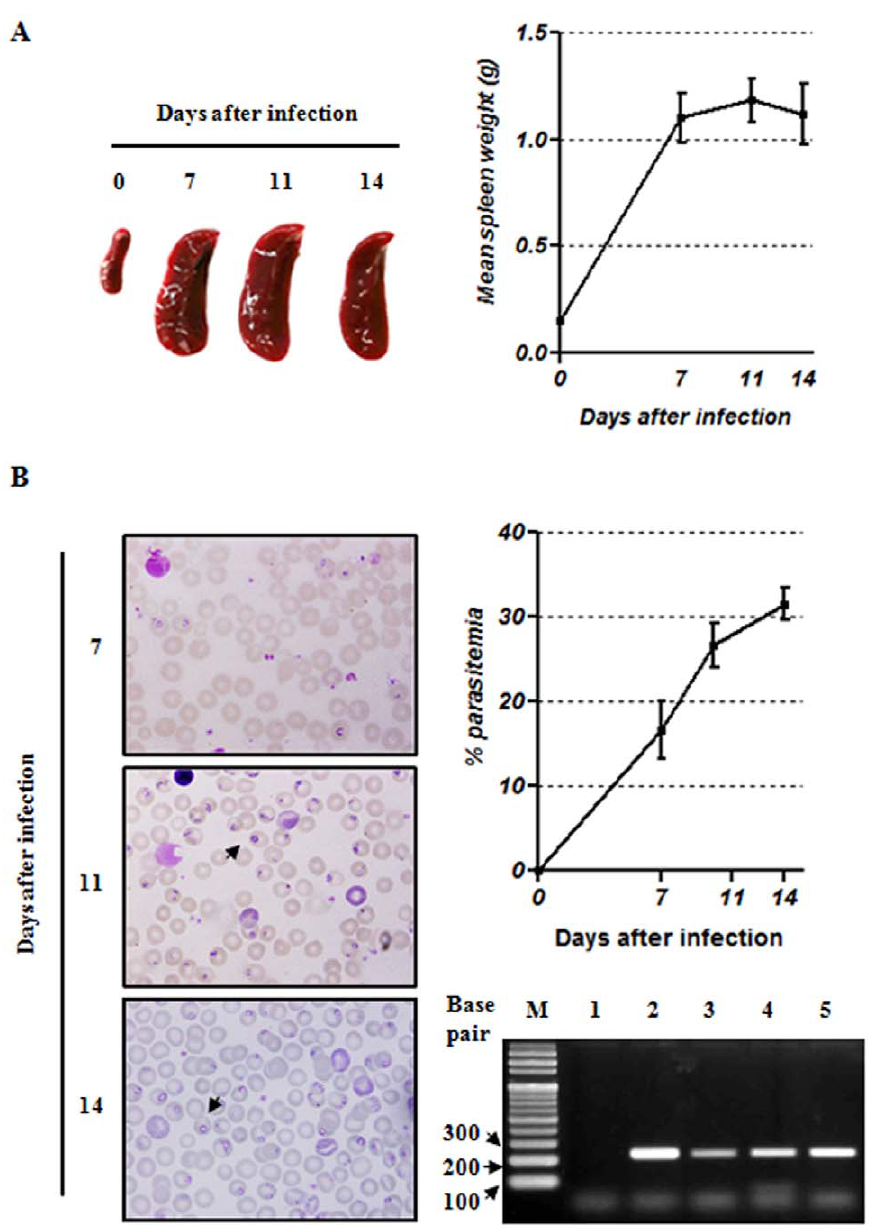
Figure 1. Enlargement of the spleen and parasitemia during the acute phase of B.microti infection. For the infection, 200 ml of an infected blood suspension (representing 20% parasitemia) was injected intraperitoneally. Control mice were injected with an equal total number of uninfected cells. (A) Enlargement and mean weight of spleens from B. microti -infected mice. (B) Identification of parasitized erythrocytes using Wright-Giemsa-stained blood smears (left panel) and the frequency of erythrocytes infected with B. microti versus the total number of red blood cells (right panel). Representative gel showing the PCR amplication of B. microti -specific 18S ribosomal ribonucleic acid genes (229 base pair segment) for the efficient detection of B. microti infection. Lane 1, negative genomic DNA control; Lane 2, positive control; Lane 3, day 7 after infection; Lane 4, day 11 after infection; Lane 5, day 14 after infection; Lane M, DNA ladder marker. All results represent at least five independent experiments with five mice in each